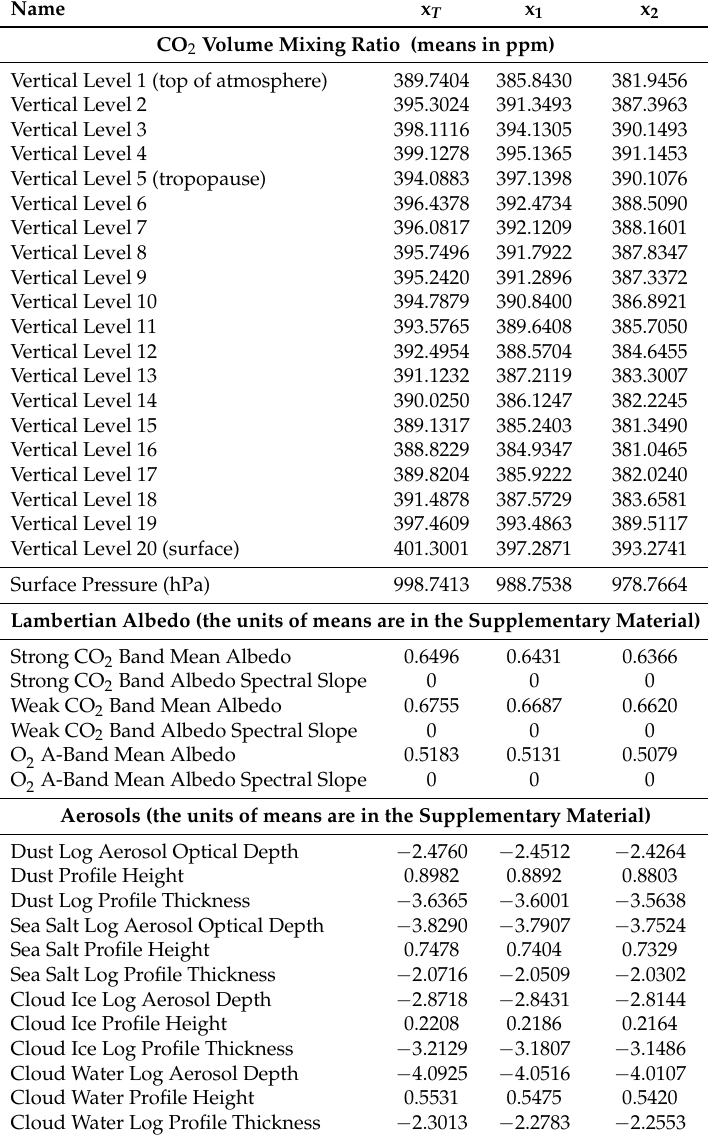
Table 2. True prior means x T and working prior means x 1 and x 2 used in the simulation. While x 1 = 0.99 x T and x 2 = 0.98 x T , we display their actual values in the third and fourth column for ease of